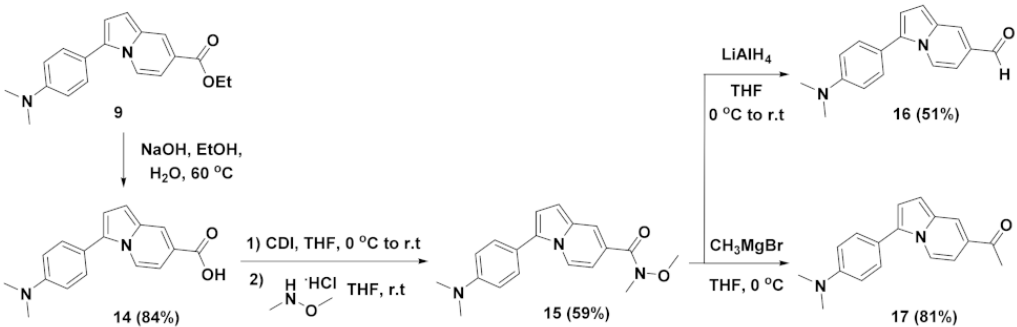
Scheme 2. Synthetic scheme for the modification of ester functional group of compound 9 at the C-7 position.